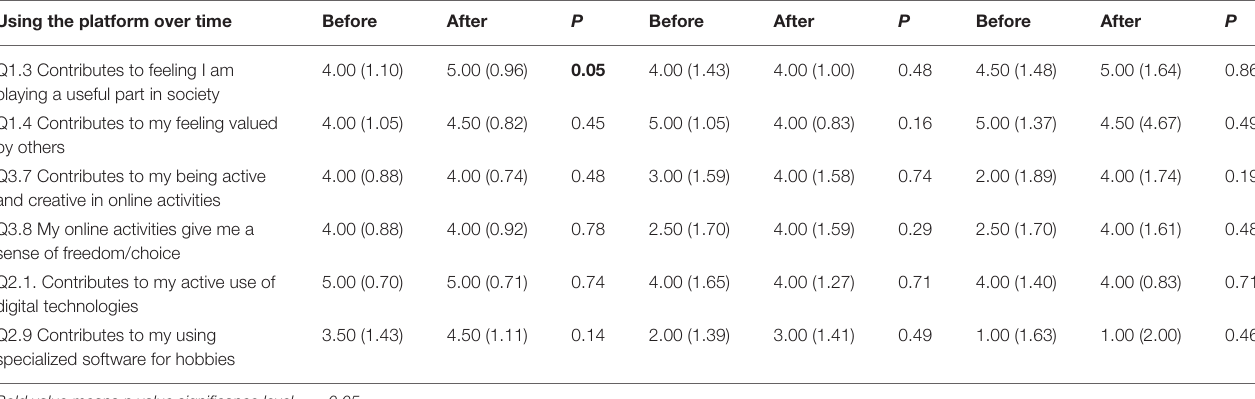
TABLE 6 | Descriptive statistics (median and standard deviation) for answers to empowerment indicator questions and comparison using Wilcoxon non-parametric statistical test. Using the platform over time Before After P Before After P P